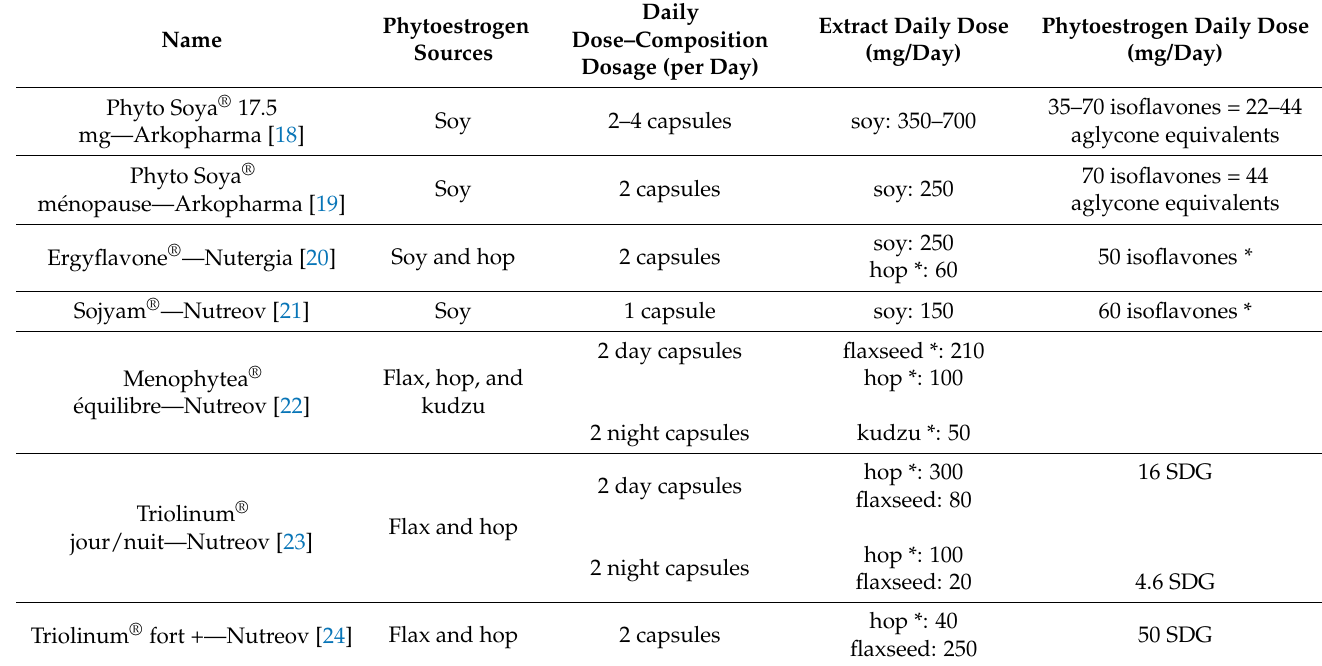
Table 3. Examples of phytoestrogen dietary supplements. * Aglycone or glycoside form not speci- fied.